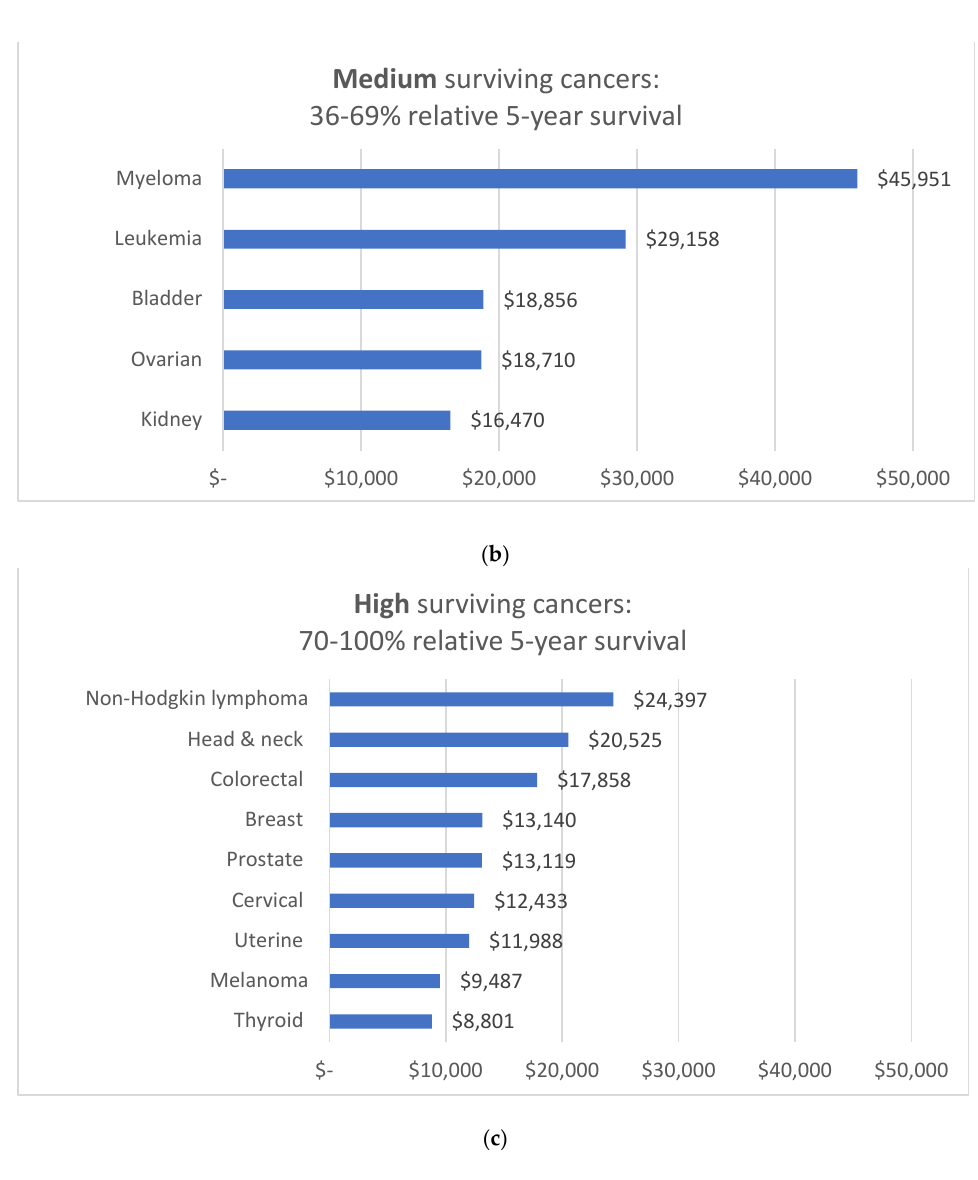
Figure 5. Mean annual healthcare costs in AU$ by ( a ) low, ( b ) medium and ( c ) high relative 5-year survival (N = 230,380).